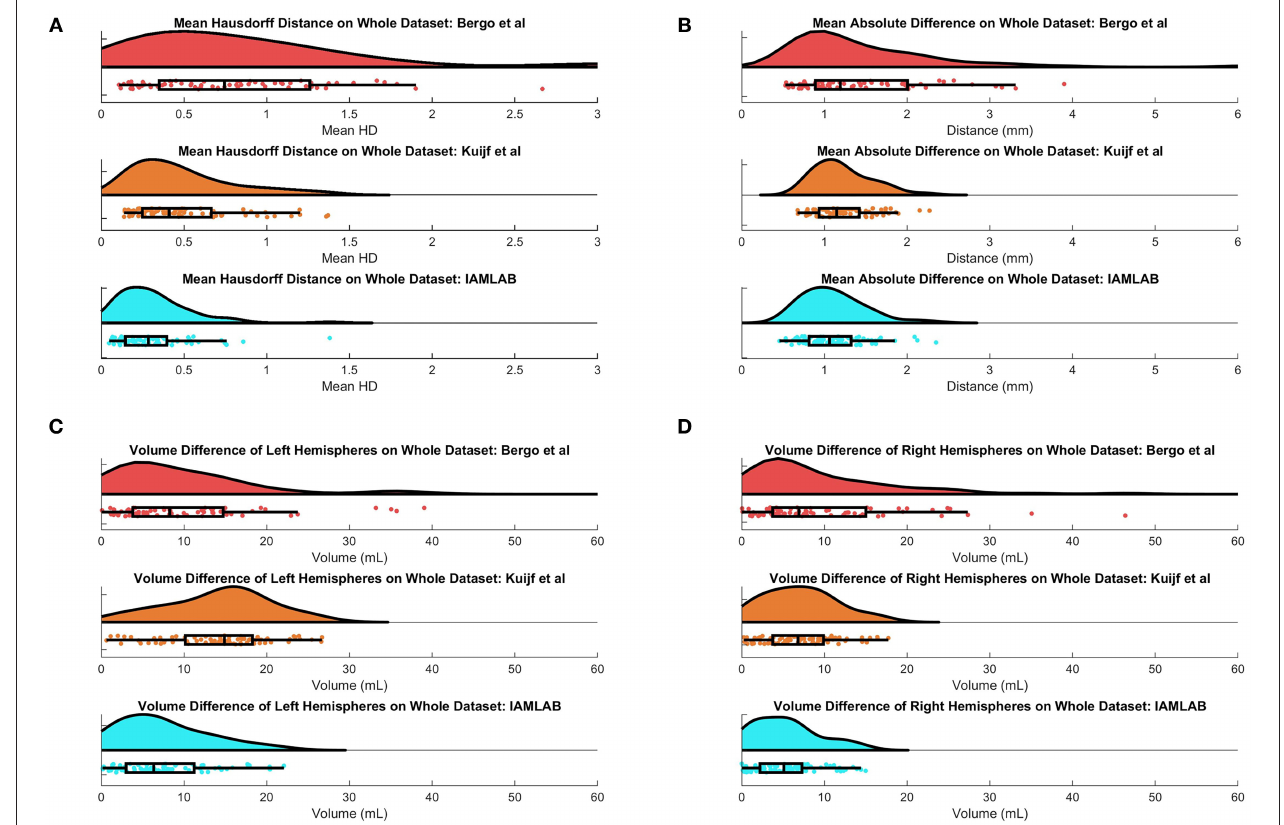
FIGURE 6 | Raincloud plots of results for (A) Mean HD, (B) MAD, (C) Left Volume Difference 1 V L , and (D) Right Volume Difference 1 V R for entire validation set (75 volumes from CAIN, ADNI, and